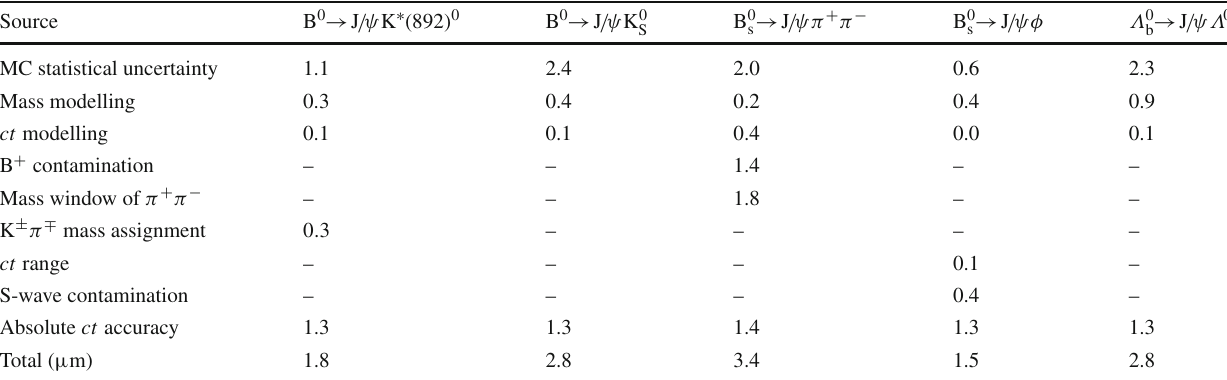
Table 1 Summary of the sources and values of systematic uncertainties in the lifetime measurements (in µ m). The total systematic uncertainty is the sum in quadrature of the individual uncertainties